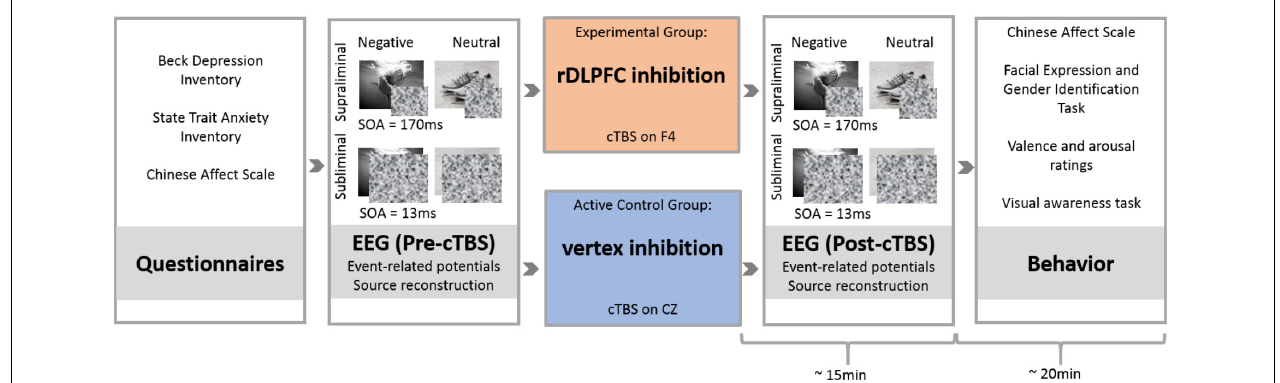
FIGURE 1 | Experimental paradigm. After completing questionnaires, participants were assigned to either the experimental or the Active Control group. In the experimental group (rDLPFC inhibition group), rDLPFC excitability was reduced by administration of inhibitory continuous Theta Burst Stimulation (cTBS) to electrode F4. The Active Control group received cTBS on CZ (vertex). Before and after cTBS-application (Pre-cTBS vs. Post-cTBS), participants viewed four blocks of backward-masked supraliminal (SOA = 170 ms) and subliminal (SOA = 13 ms) negative (e.g., shark) and neutral (e.g., shoes) scenes. Thereby, each of the overall eight blocks contained a different set of 50 images to avoid the emergence of familiarity effects or habituation through repetition of identical images across blocks. Within each block, each image was presented three times. The assignment of images to blocks was counterbalanced across subjects. Following EEG measurements, participants completed behavioral tasks in order to evaluate effects of cTBS stimulation on self-reported mood (CAS), on attention engagement to and disengagement from emotional stimuli (Facial Expression and Gender Identification Task), on valence and arousal ratings of images, and on discrimination of negative versus neutral images under supra- and subliminal viewing conditions (visual awareness task). All post-cTBS measurements were completed within 35 min after